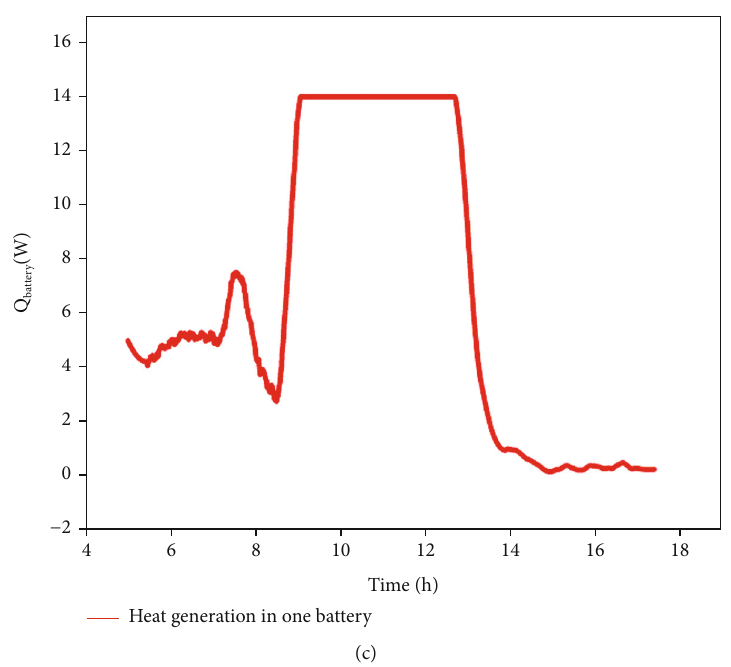
Figure 6: Battery heat generation behaviors: (a) experiment data, (b) simulated data, and (c) input